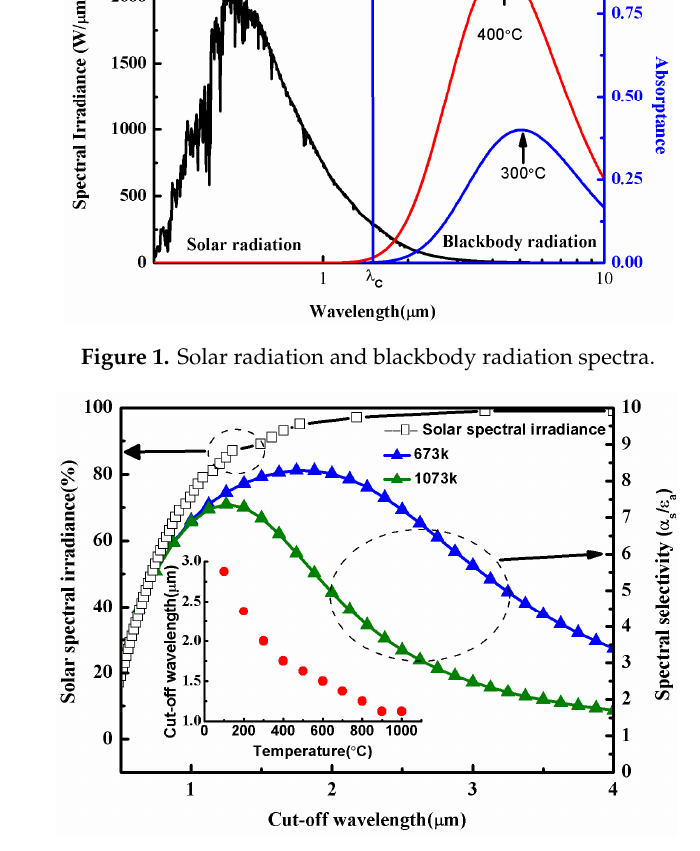
Figure 2. Change of solar selectivity α / ε at 673 and 1073 K with the cut-off wavelength; the optimal cut-off wavelength at different temperatures of 100–1000 °C.